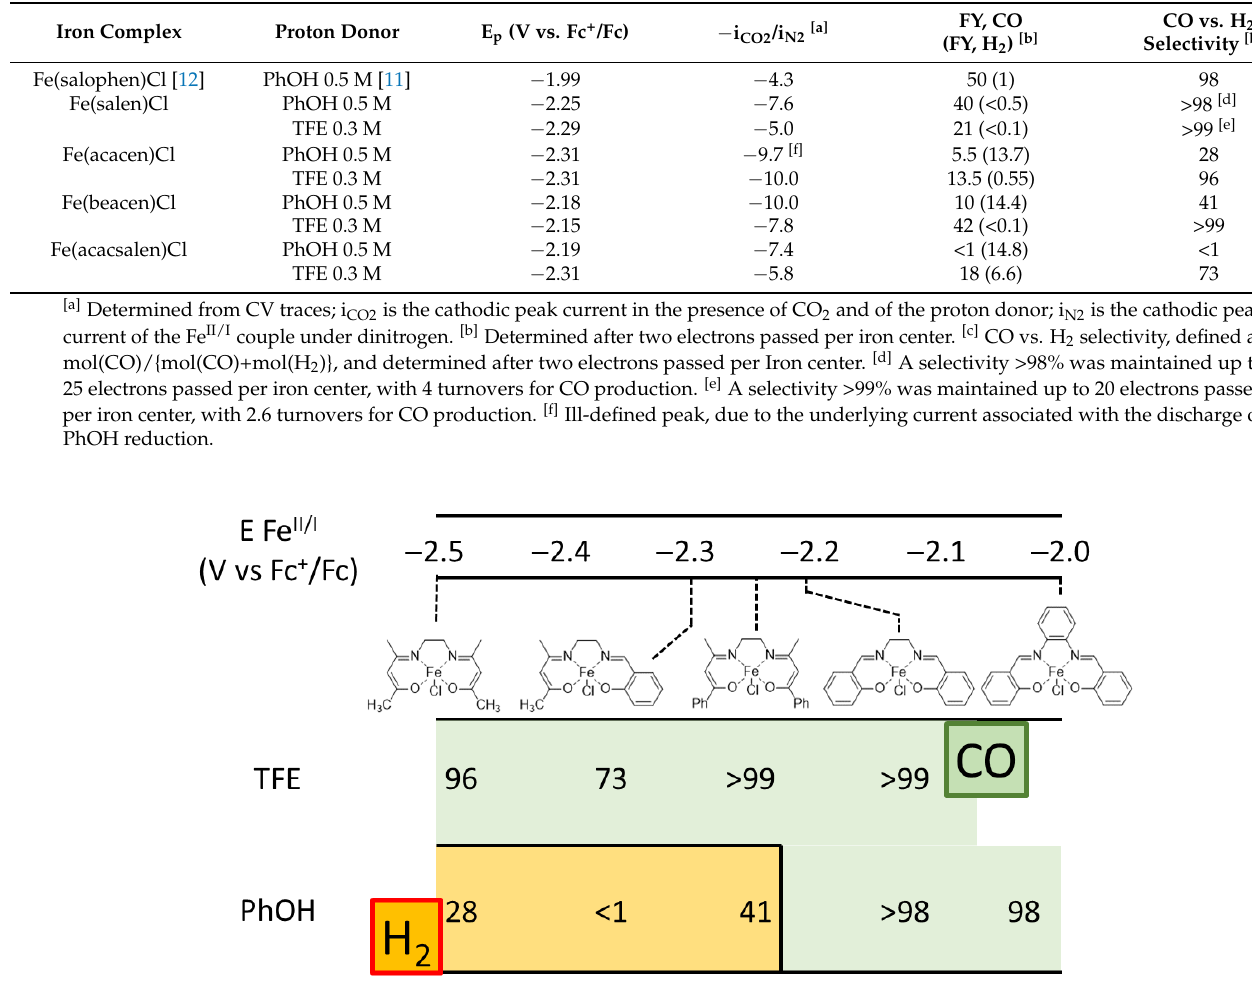
Table 2. Electrochemical reduction of CO 2 with iron complexes in the presence of phenol (PhOH) or trifluoroethanol (TFE) proton donors.